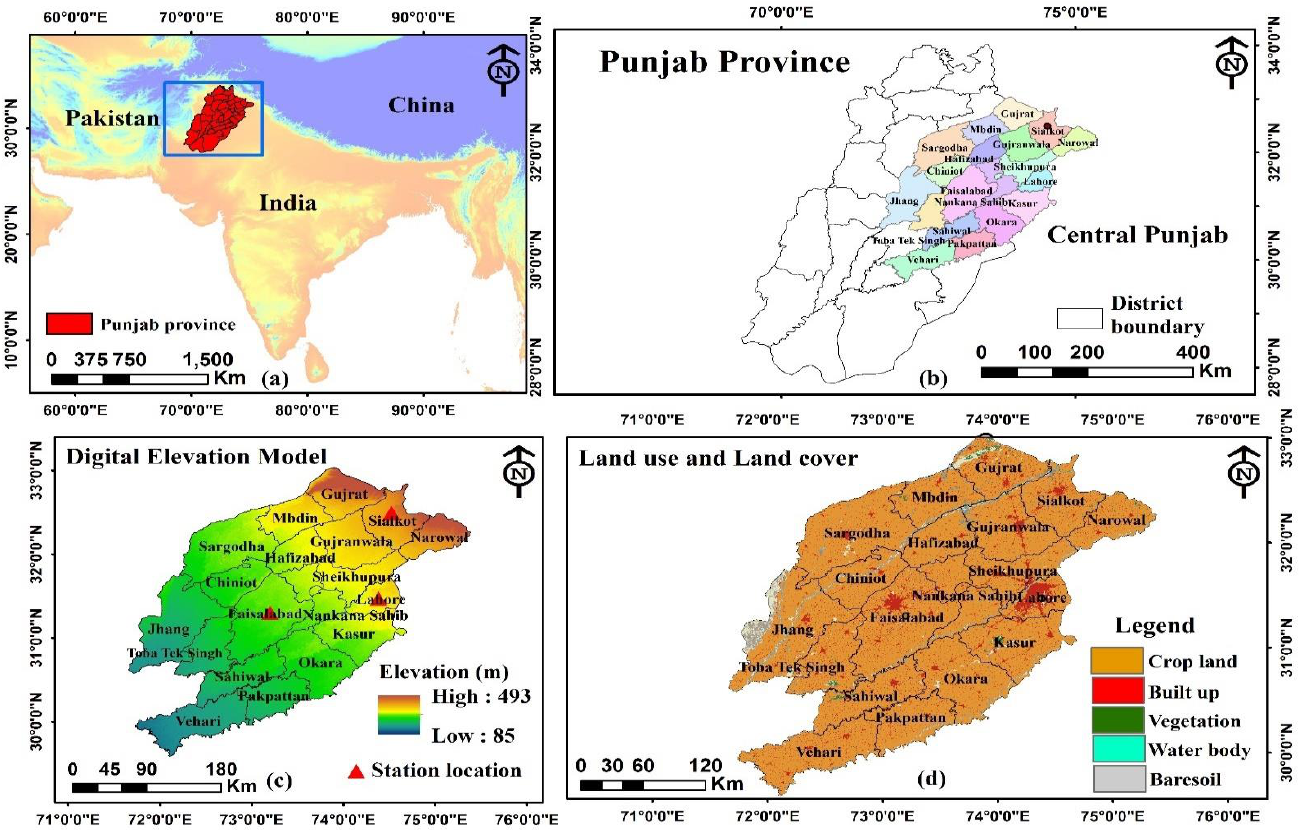
Figure 1. ( a ) Location of central Punjab, Pakistan; ( b ) Districts of central Punjab region; ( c ) Digital elevation model of central Punjab with PMD metrological observatories; ( d ) District-wise land use and land cover pattern of central Punjab.